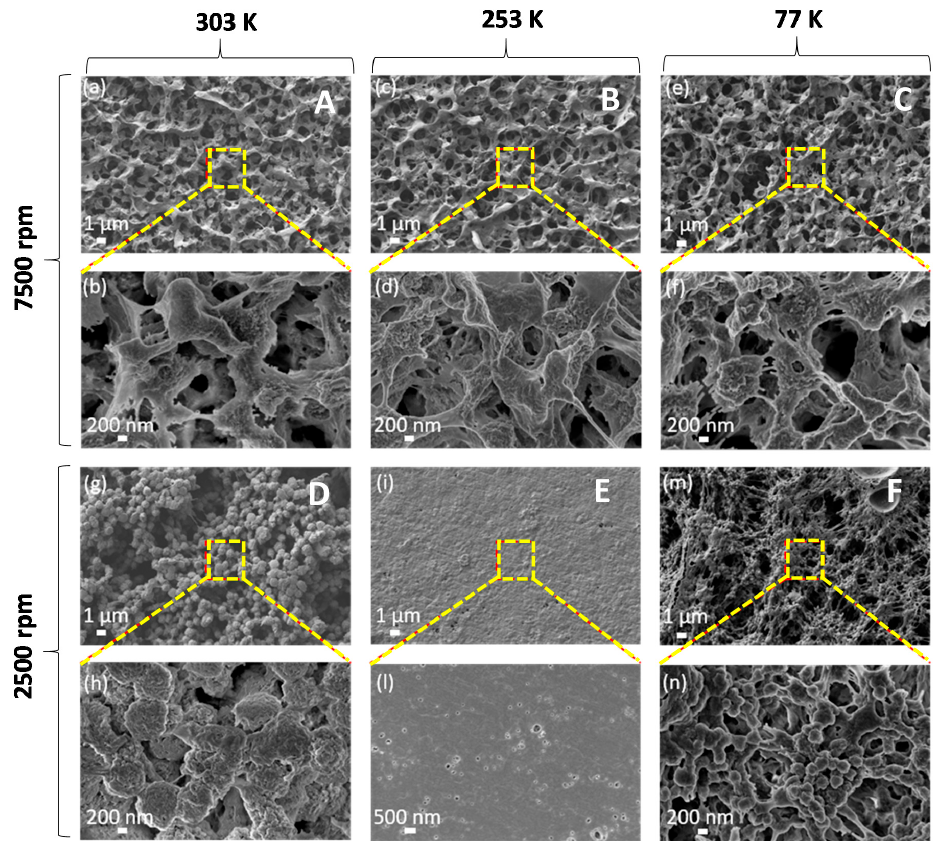
Figure 2. FE-SEM low-magnification ( a , c , e , g , i , m ) and high-magnification ( b , d , f , h , l , n ) micrographs of PVDF films with polymer content of 20 wt.%., produced at spin-coater rotation speed of 7500 rpm (samples A, B, C) or 2500 rpm (samples D, E, F), and quenched at 303 K in water (samples A, D) or at 253 K in water and glycerol (samples B, E) or at 77 K in liquid nitrogen (samples C, F).